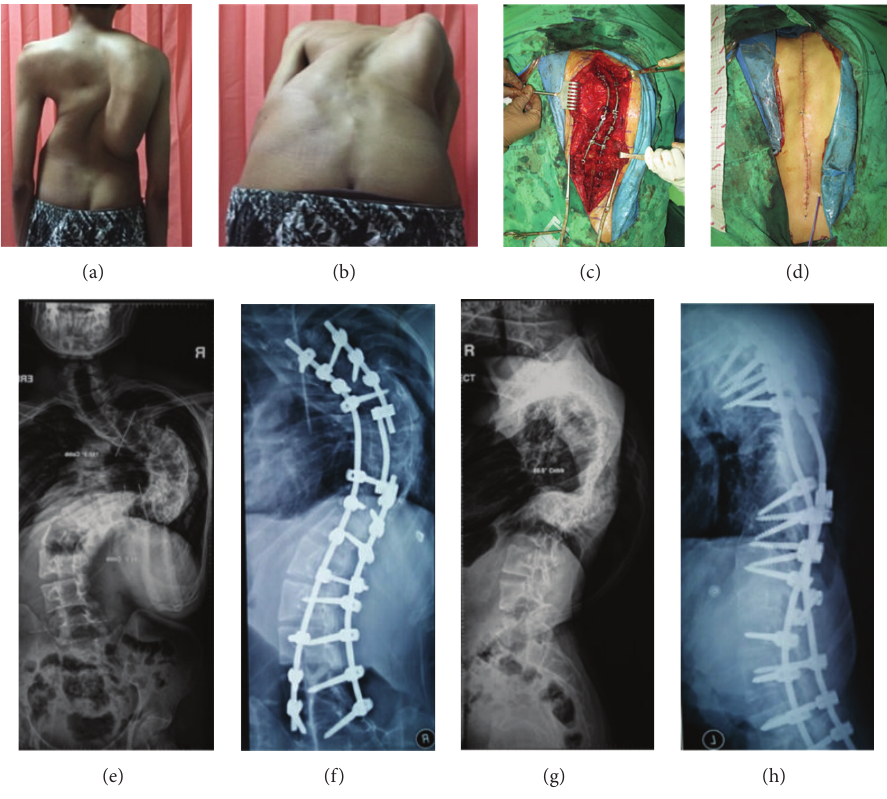
Figure 2: (a) and (b) Clinical picture on standing and forward bending position. It shows right rib hump and asymmetry of right and left back. (c) Intraoperative picture after rod and screw placement and manipulation. (d) Postoperative picture after suturing midline incision on back area. It shows asymmetry improvement of rib hump and balance. (e) Posterolateral view of cervicothoracolumbar spine before surgery manipulation. (f) Posterolateral view of thoracolumbar spine after surgery using rod and screw corrective manipulation technique. (g) Lateral view of cervicothoracolumbar spine before surgery manipulation. (h) Lateral view of thoracolumbar spine after RSCM technique